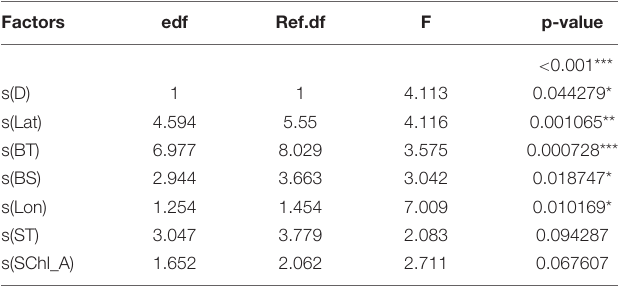
TABLE 1 | Approximate significance of smooth terms.